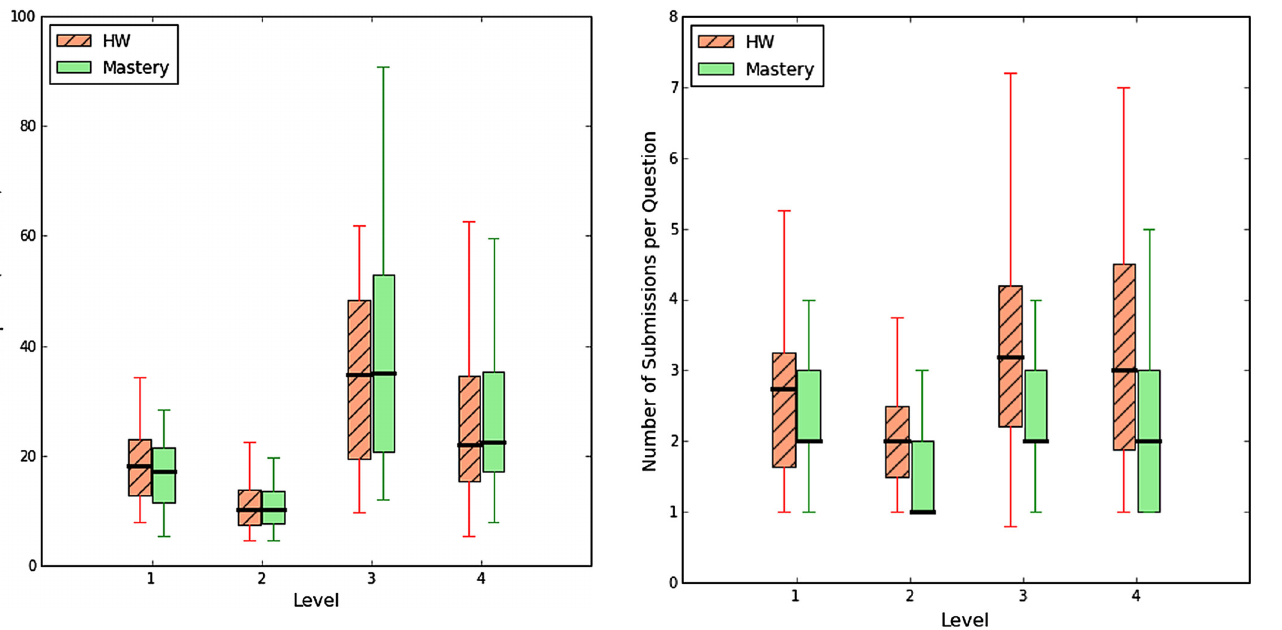
FIG. 2. Box plot of the number of submissions per question on each level. Median values are reported in the black line in the center of each box, and the boxes represent the interquartile range (IQR ¼ Q 3 -Q 1 ). Whiskers represent, for example, for the top whisker, most extreme value within 1 . 5 × IQR þ Q 3 . Outliers are not shown. The mastery group had fewer median submissions per question for all